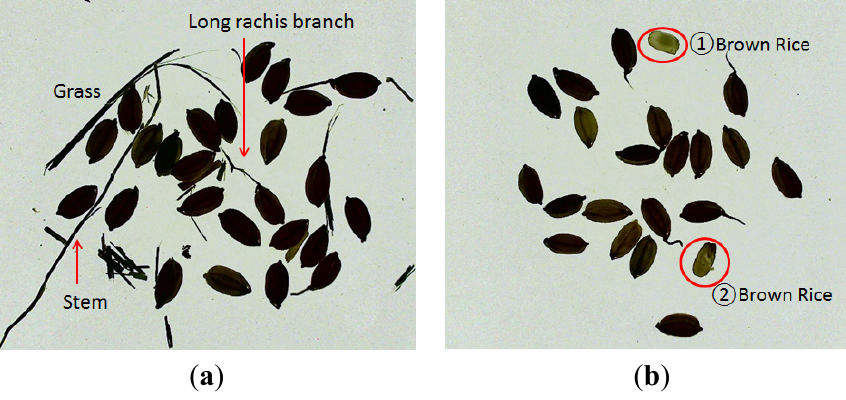
Figure 9. Image using frontlight images. ( a ) Long rachis branch, grass and stem; ( b ) 2 types of brown rice.